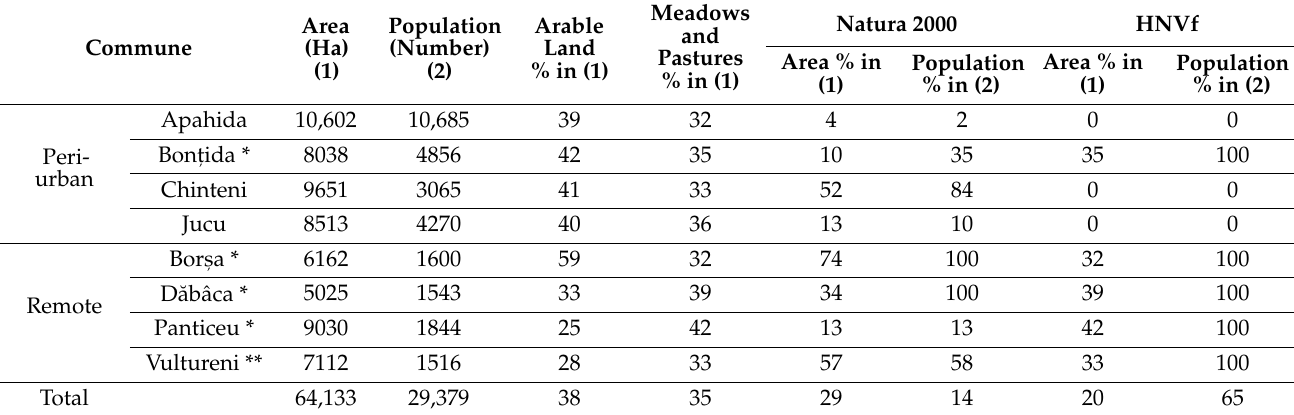
Table 1. Key statistics for the study area (in